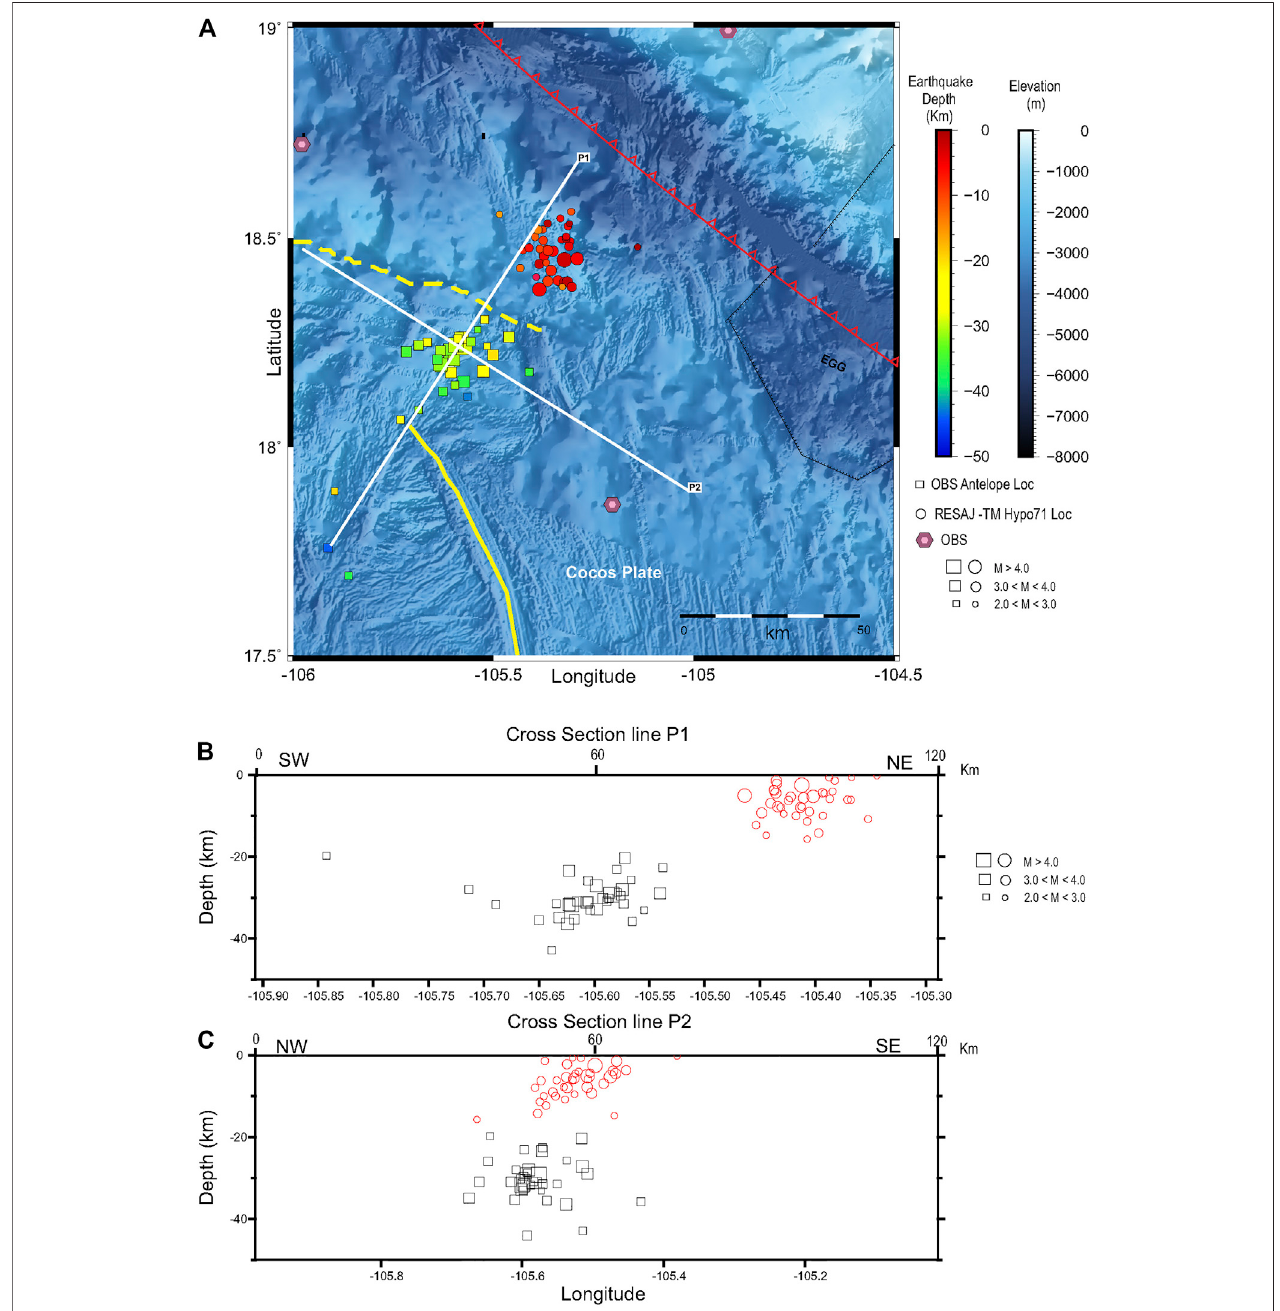
FIGURE3| LocationsoftheseismicsequenceoccurredonMay7 – 10,2016(86earthquakes)withAntelopeandHypo-71. (A) Epicentralmap( fi llcolorproportional todepth),wheresquaresymbolsdenoteearthquakeslocatedwithOBSdatalocatedusingAntelopesystemandvelocitymodeliasp91.Incontrast,circlesrepresentthe RESAJandTNdatalocationsusingHypo-71andP-wavevelocitymodelVJB01(Núñez-Cornúetal.,2002). (B) Cross-sectionalonglineP1. (C) Cross-sectionalongP2 line. Pink hexagons depict OBS locations.